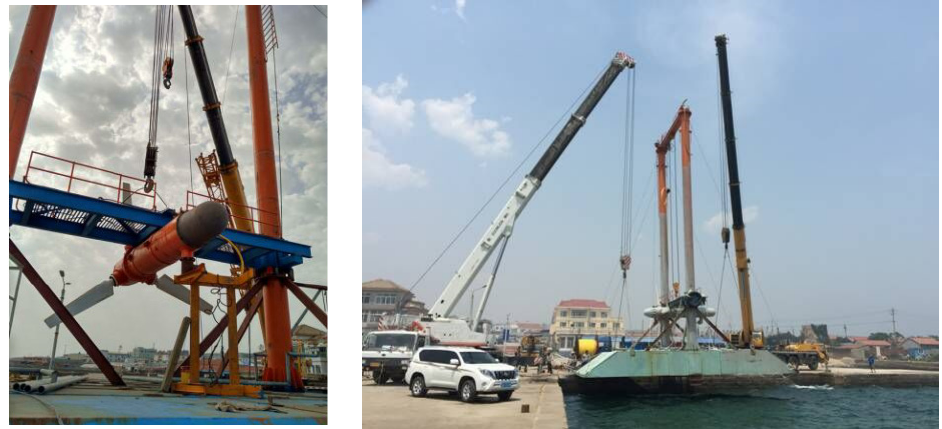
Figure 25. “Haichuan”—20 kW horizontal-axis variable-pitch TCPGS. Reproduced from [70].